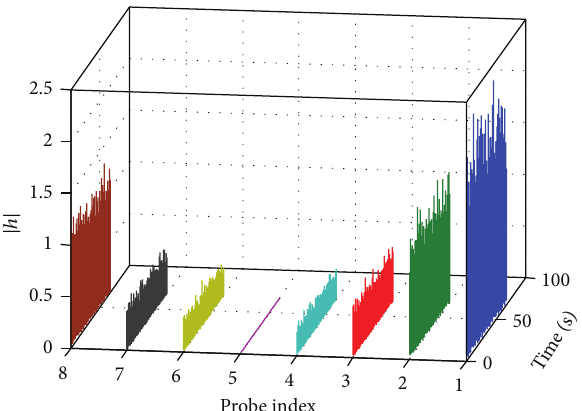
Figure5:AnillustrationoftheweightedCIRsfromtheeightequally located probes with 𝑁 𝑑 = 8